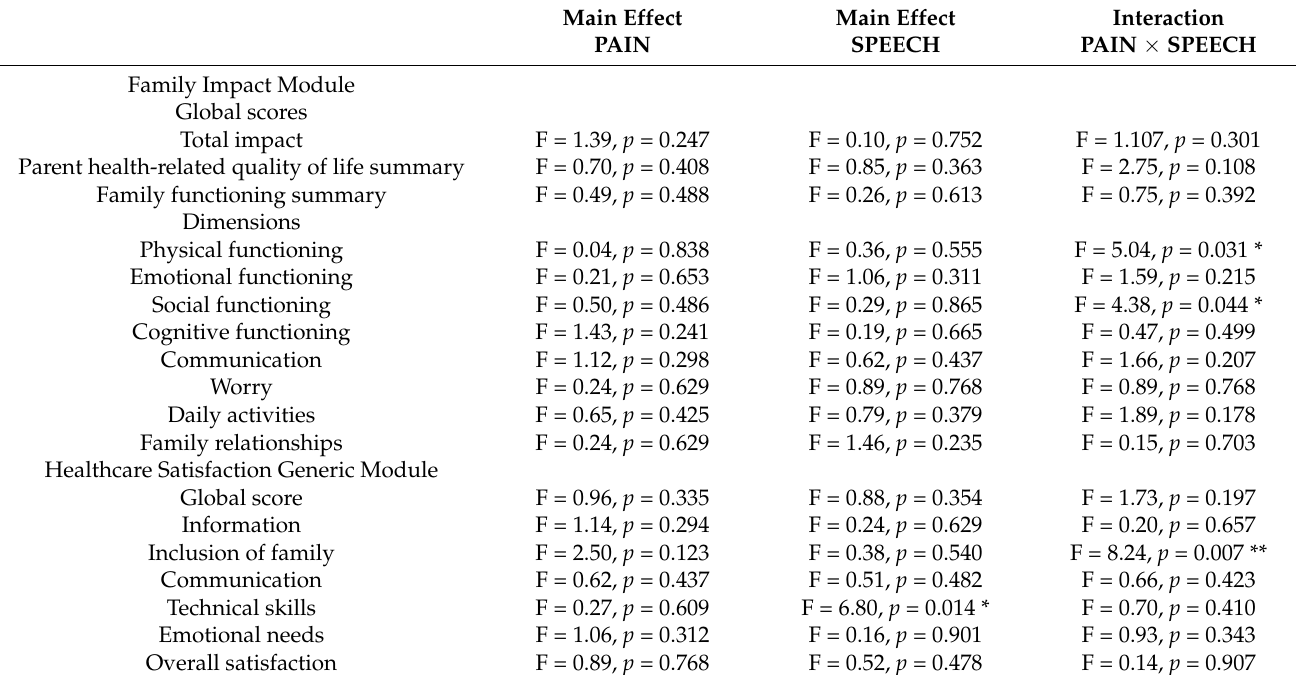
Table 4. Statistical values of group comparisons in all the different dimensions of the Family Impact and Healthcare Satisfaction modules. Two-way ANOVAs, with PAIN (children with pain vs. children without pain) and SPEECH (children with speech ability vs. children without speech ability) as between-subject factors. * p < 0.05, ** p <